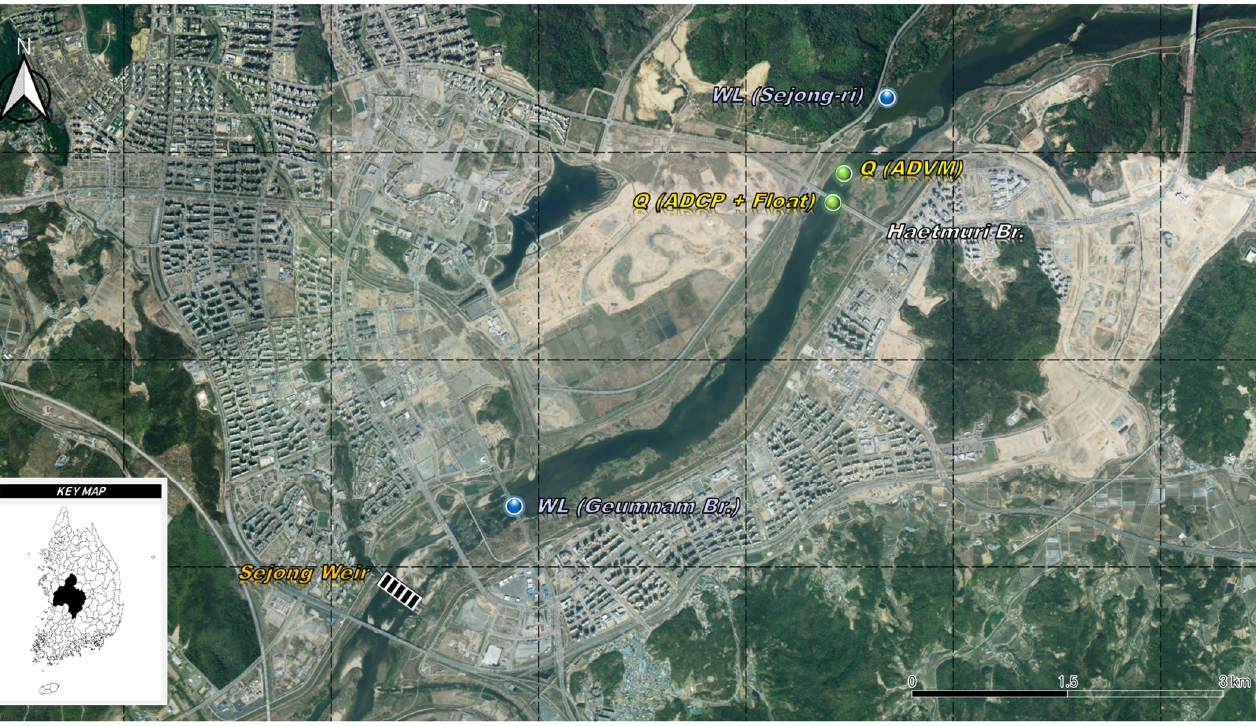
Figure 1. Locations of measuring water level and discharge. Table 1. Location and specifications of the gauging